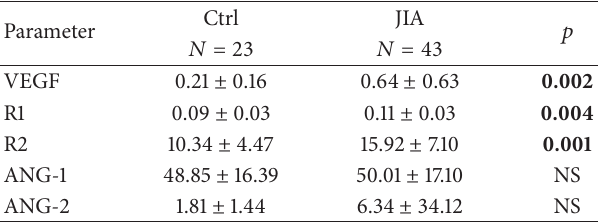
Table 2: Serum levels of angiogenic proteins in JIA in comparison to healthy children.